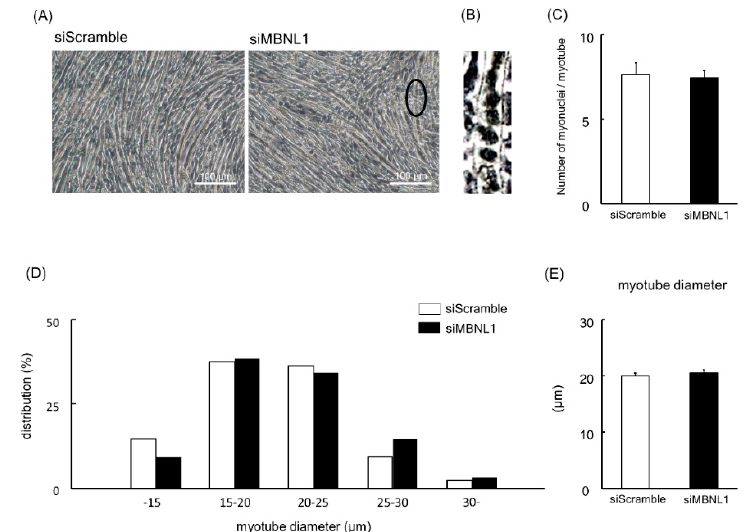
Figure 2. E ff ects of MBNL1 knockdown on the morphology of C2C12 myotubes. ( A ) Typical images of C2C12 myotubes. The ellipse in black in the image of MBNL1 indicates the enlarged area that is shown in panel B. ( B ) Enlarged image of the ellipse in black in the image (siMBNL1) in panel A. ( C ) The number of nuclei per myotube. ( D ) The frequency distributions of myotube diameter. ( E ) The average of myotube diameter. siScramble: scrambled nontargeting siRNA, siMBNL1: targeting siRNA for MBNL1. Values are means ± SEM; n = 6 per